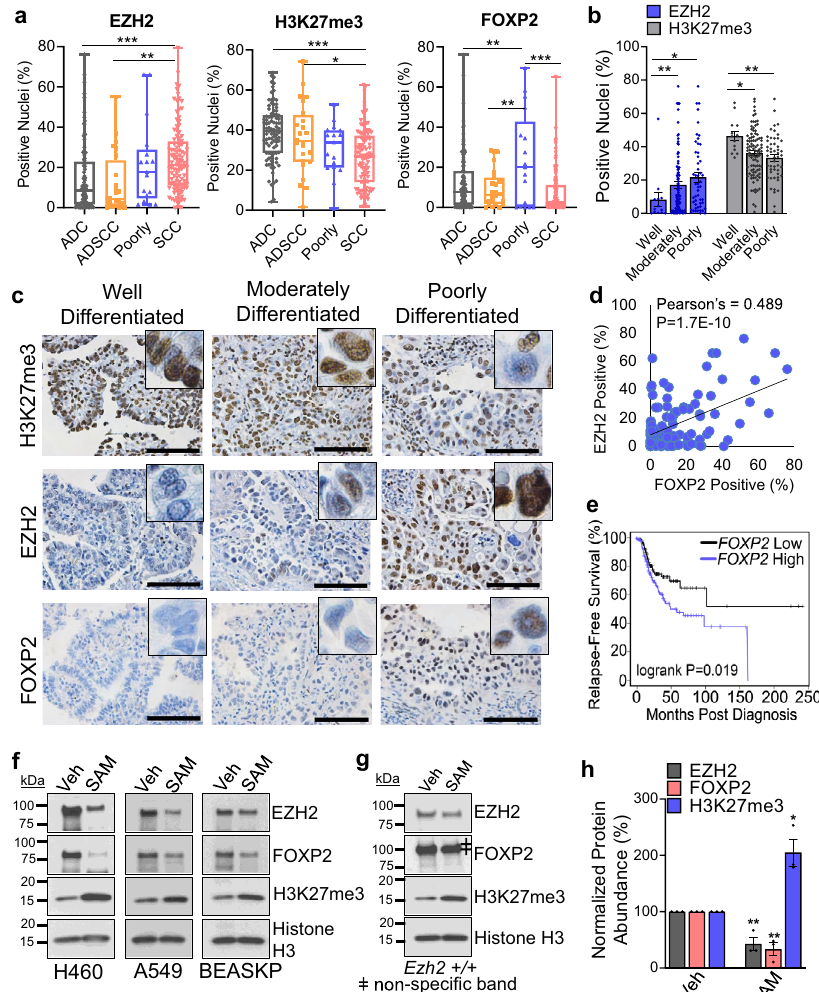
Fig. 7 | Decoupling of EZH2 from PRC2 activity may explain co-expression of EZH2 and FOXP2 in patient samples. a Positively stained tumor nuclei in ADC, ADSCC, poorly differentiated tumor and SCC specimens for the markers EZH2, H3K27me3 and FOXP2 plotted as box-and-whisker plots, error bars are min – max, box bounds are 25th and 75th percentiles and center line is median. * indicates P =0.0164,**indicates P <0.0084,***indicates P <0.0006byone-wayANOVAwith multiple comparisons and Holm – Š ídák ’ s post hoc test. n =92, 24, 17, 104 for ADC, ADSCC, poorly differentiated and SCC individual tumors, respectively. b The per- centageofEZH2andH3K27me3positivenucleiinlungadenocarcinomaandpoorly differentiated cancer specimens. * indicates P <0.0425, ** indicates P <0.0086 by one-wayANOVAwithmultiplecomparisonsandHolm – Š ídák ’ sposthoctest. n =13, 51, 97 for well, moderately, poorly differentiated individual tumors, respectively. c Representative images of lung adenocarcinoma specimens de fi ned as well, moderately, and poorly differentiated stained for the indicated markers, scale